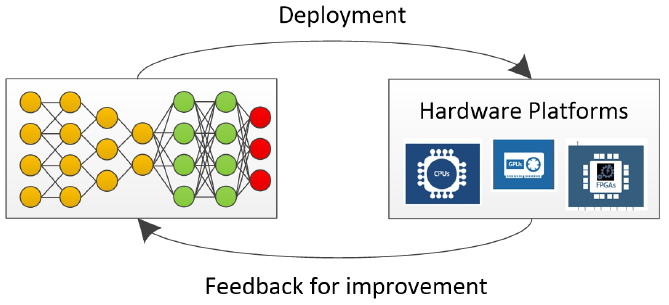
Figure 9. Co-optimizing DNNs and their underlying hardware